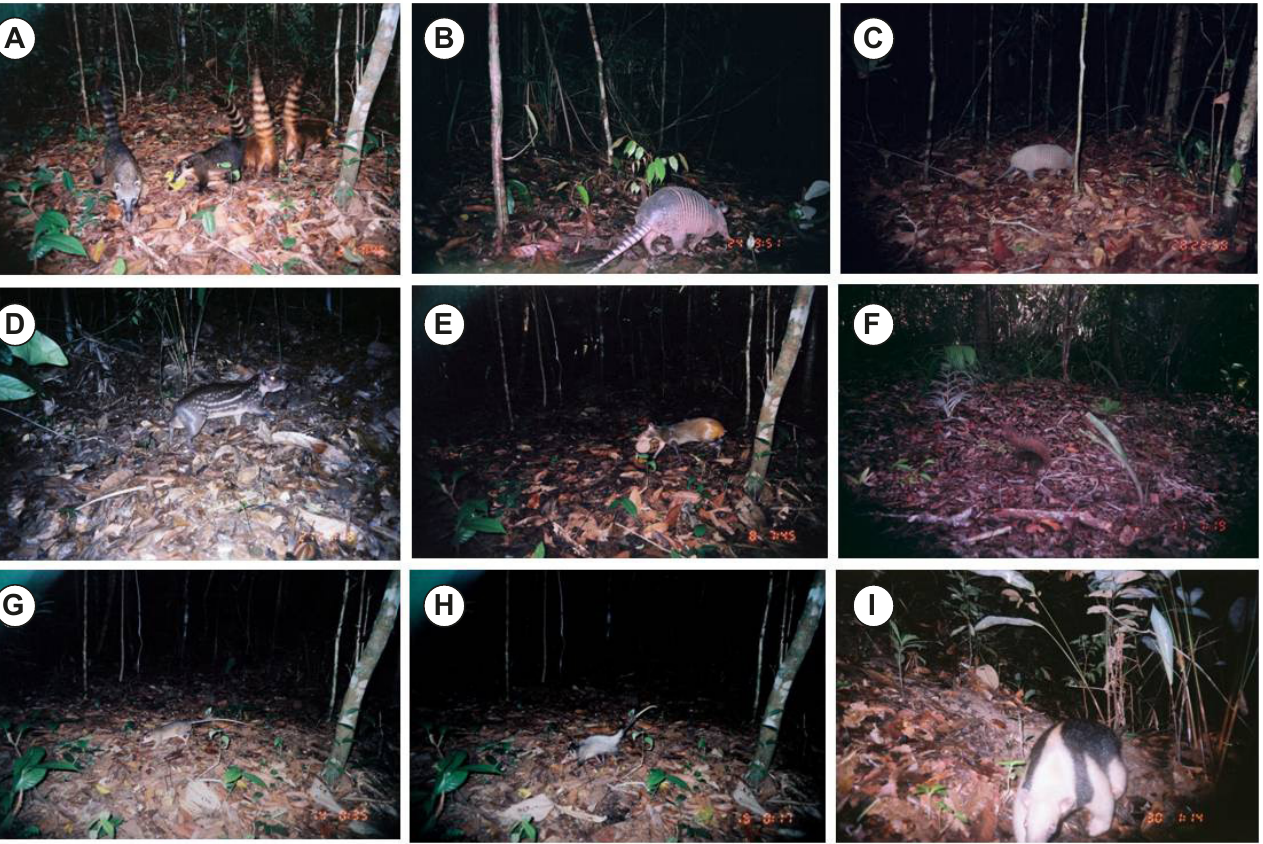
Figure 8. Other mammals recorded by camera traps in RPPN Estação Veracel. (a)